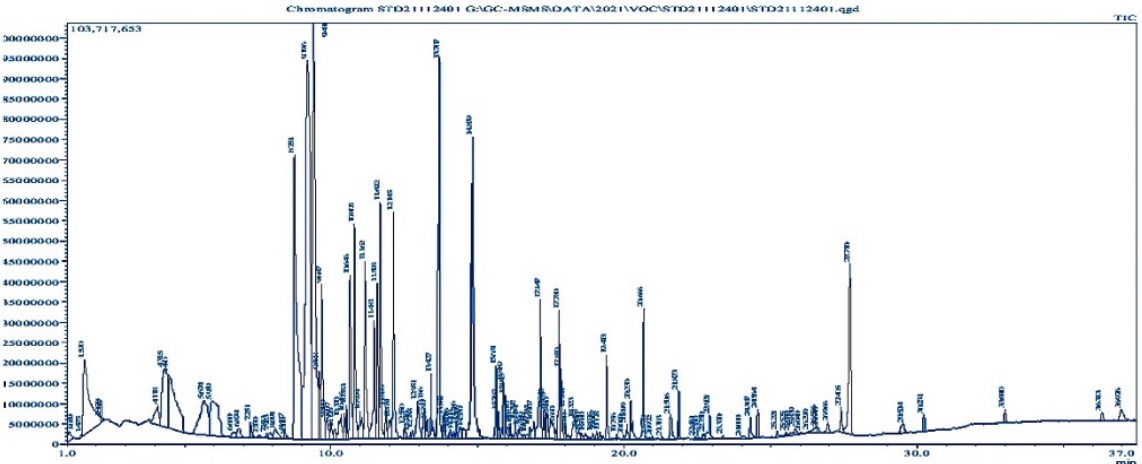
Figure 3. GC-MS chromatogram showing various bioactive compounds of Bacillus subtilis Figure 3. GC ‐ MS chromatogram showing various bioactive compounds of Bacillus subtilis.